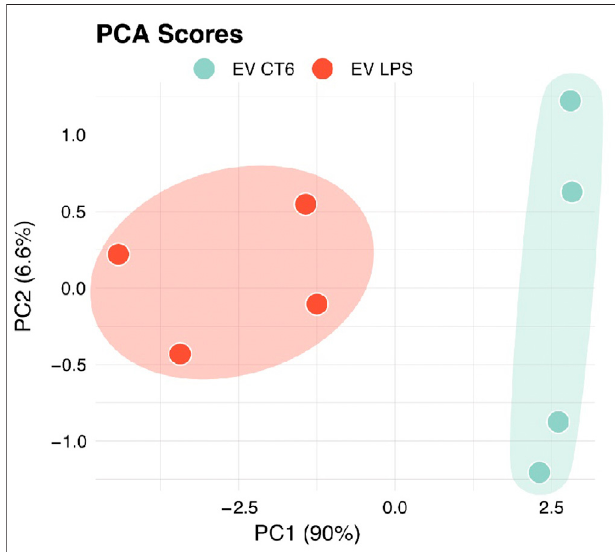
FIGURE 10 | Principal component analysis score plot of EV-CT6 and EV-LPS.EVswereisolatedfromtheculturemediaofRAWcellsincubatedwith (EV-LPS) or without (EV-CT6) LPS-EK. Proin fl ammatory cytokine protein levels (IL-1ß, IL-2, IL-4, IL-5, IL-6, IL-10, IL-12p70, TNF- α , IFN- γ , and KC-GRO) were measured in EVs derived from the macrophages using an MSD multiplex immunoassay.PCA analysisscoreplot isperformed usingfour independent experiments ( n = 4).